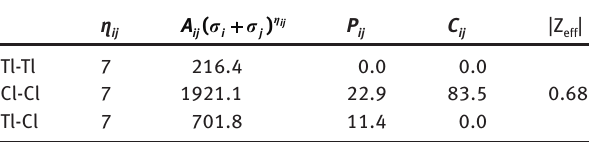
Table 1: The values of parameters of potential for TlCl.